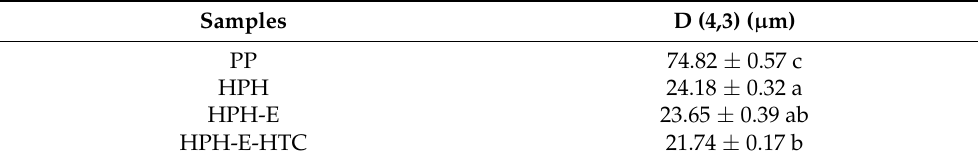
Data are expressed as means ± SD. Superscript characters (a – c) indicate significant ( p < 0.05) differences in the same column.